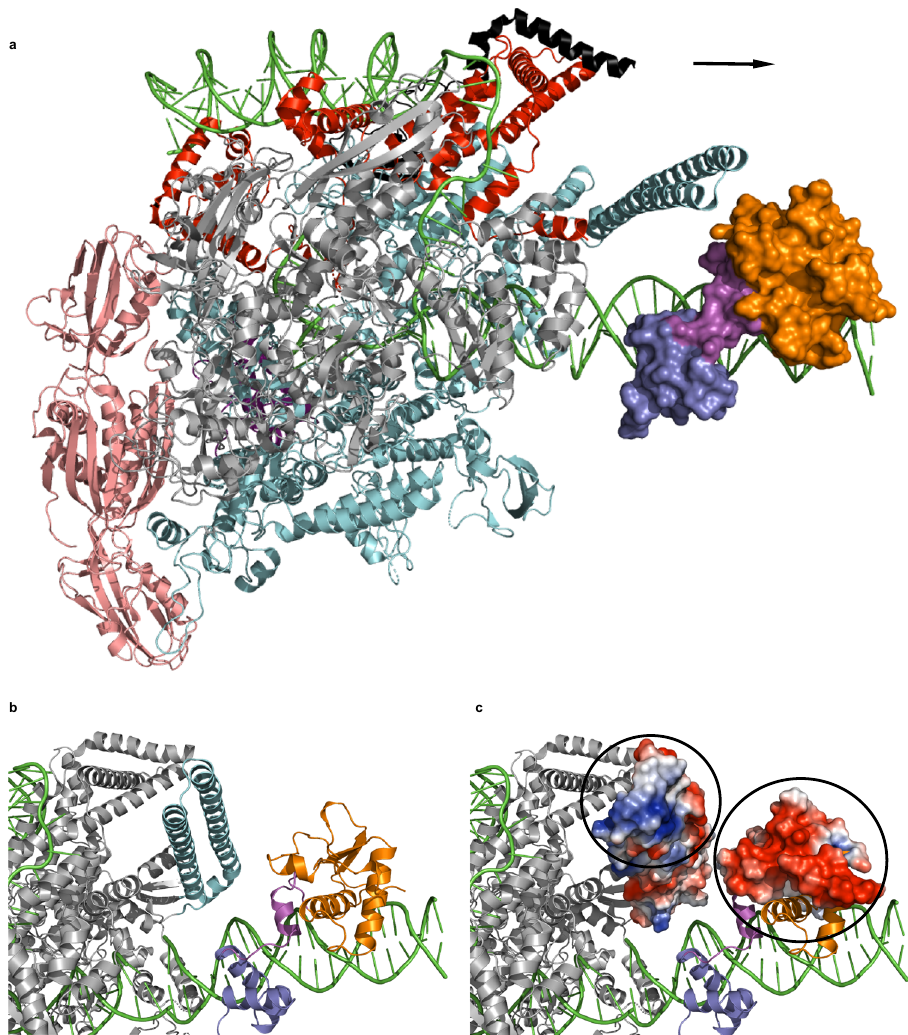
Fig. 7 Model for transcriptional silencing in cluster A mycobacteriophages. a The Mycobacterium smegmatis RNA polymerase (PDB 5VI5) is colored as follows: α subunits: pink, β subunit: gray, β ′ subunit: cyan, ω subunit: dark purple, σ A subunit: red, and RNA polymerase-binding protein RBPA: black. The TipsytheTRex repressor is shown in surface view and colored as in Fig. 1a, and it has been rotated forward by ∼ 90° relative to the orientation observed in Fig. 1. All nucleic acid in the fi gure is colored green, and the direction of transcription is indicated with an arrow. The repressor may inhibit transcription elongation by either serving as a steric block or by halting the polymerase via protein:protein interactions. b Zoomed in view showing the position of the RNA polymerase β ′ insert (colored cyan) relative to the C-terminal region of the Stoperator domain of the repressor (colored orange). The remaining regions of the RNA polymerase are colored in gray for clarity. c Same view as in panel b but with electrostatic potentials shown (red: negative potential, blue: positive potential, white: neutral) for the RNA polymerase β ′ insert and C-terminal region of the Stoperator domain of the repressor. Circles are drawn around areas of positive and negative charge for the β ′ insert and C-terminal region of the repressor,